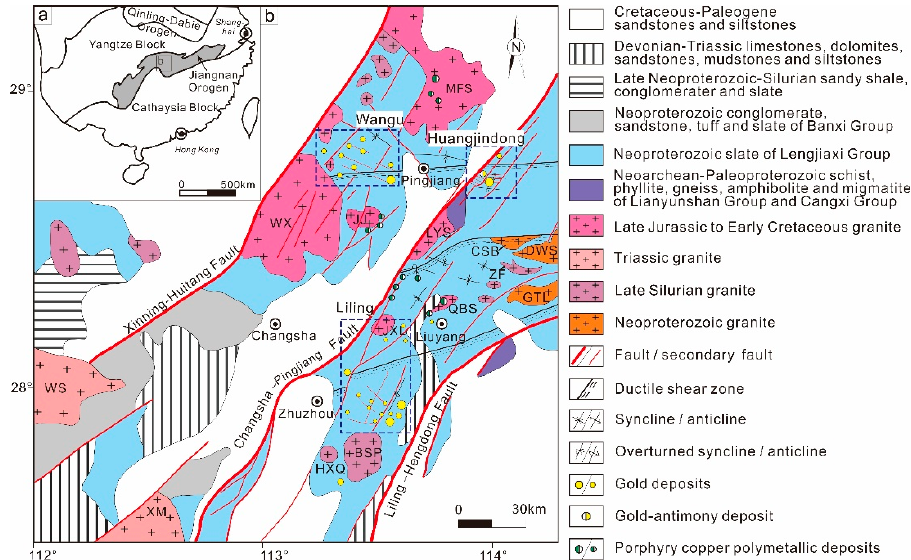
Figure 1. ( a ) Location of Jiangnan Orogenic Belt (JOB); ( b ) Geological map of the Changsha-Pingjiang metallogenic belt showing the distributions of gold deposits. Abbreviations for granites: BSP, Banshanpu; CSB, Changsanbei; DWS, Daweishan; GTL, Getengling; HXQ, Hongxiaqiao; JJ, Jinjing; JXL, Jiaoxiling; LYS, Lianyunshan; MFS, Mufushan; QBS, Qibaoshan; WS, Weishan; WX, Wangxiang; XM, Xiema; ZF, Zhangfang. Modified from references [26,27].